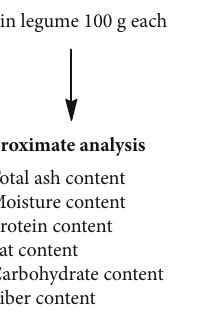
Figure 1: Flowsheet diagram of the composition analysis and biological activities of legume